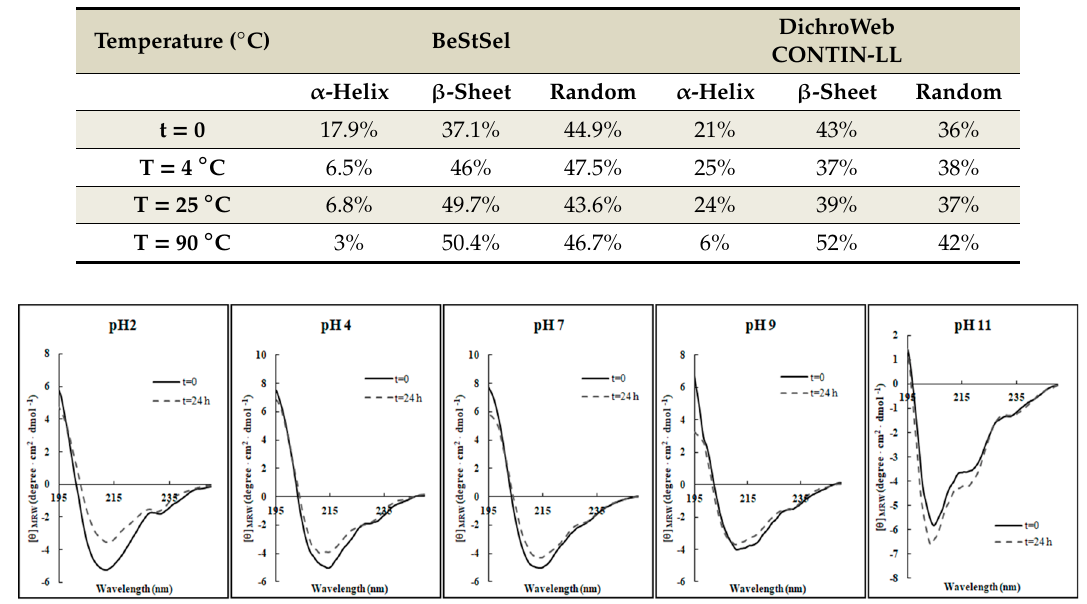
Figure 2. E ff ect of the temperature on the secondary structure of RiLK1. Far-UV CD spectra of the Figure 2. Effect of the temperature on the secondary structure of RiLK1. Far ‐ UV CD spectra of peptide (0.1 mg / mL) were acquired in 10 mM Tris-HCl bu ff er pH 7.0 in the presence of 3 mM SDS at the peptide (0.1 mg/mL) were acquired in 10 mM Tris ‐ HCl buffer pH 7.0 in the presence of 3 three di ff erent temperatures (4 ◦ C, 25 ◦ C, and 90 ◦ C) after 24 h incubation. mM SDS at three different temperatures (4 °C, 25 °C, and 90 °C) after 24 h incubation. Table 3. Secondary structure contents of RiLK1 at di ff erent temperatures in the absence or presence of SDS (3 mM) determined by BeStSel and DichroWeb server.